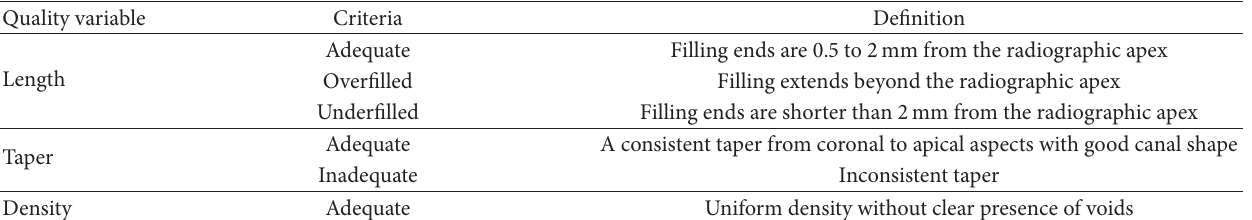
Table 2: Criteria for the evaluation of root canal